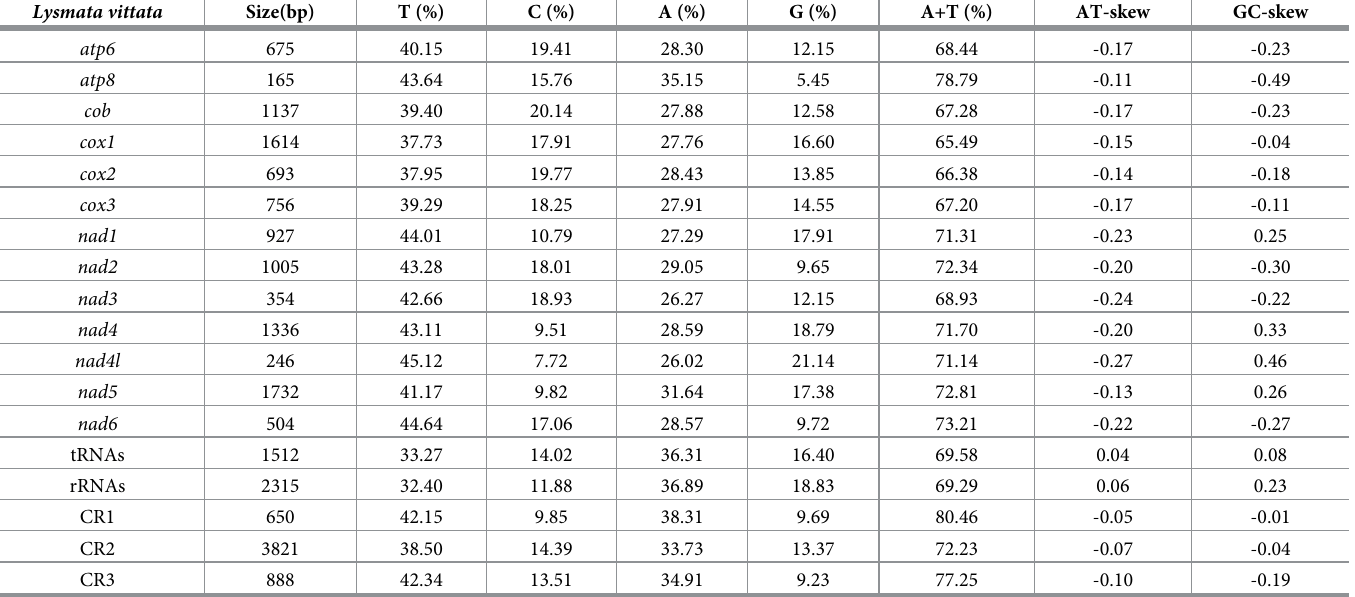
Table 2. Composition and skewness of Lysmata vittata mitogenome. Lysmata